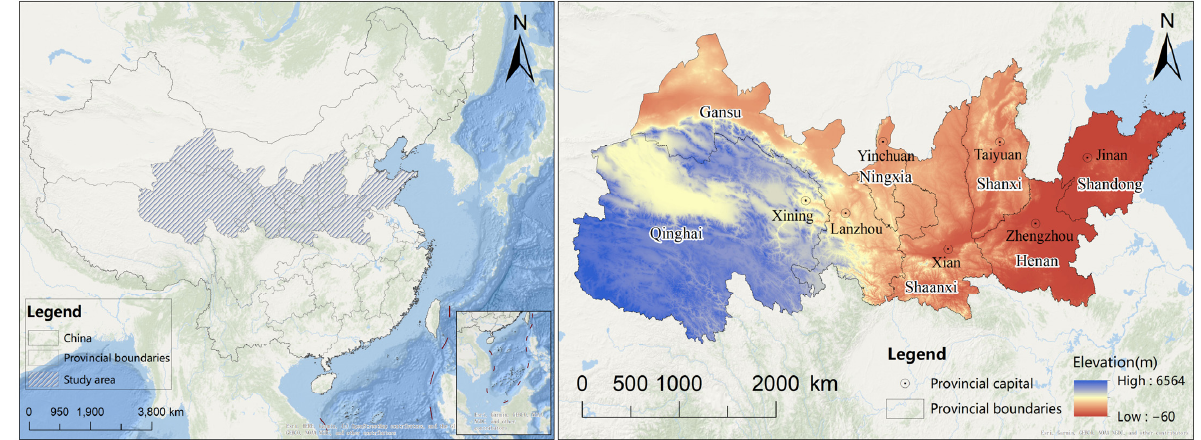
Figure 1. Location of the Yellow River Ecological Economic Belt Area.